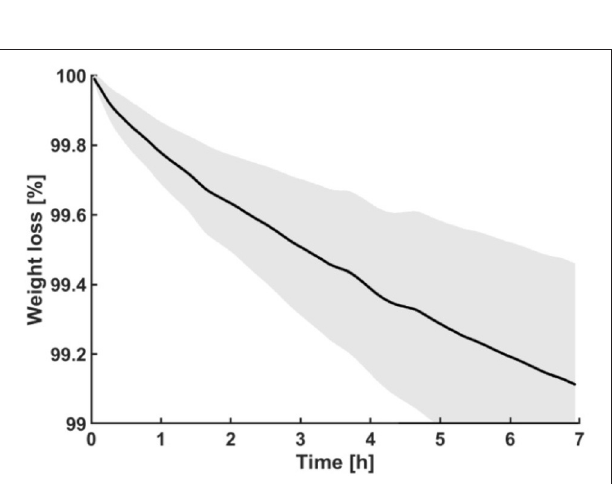
3) over time. The gray area =